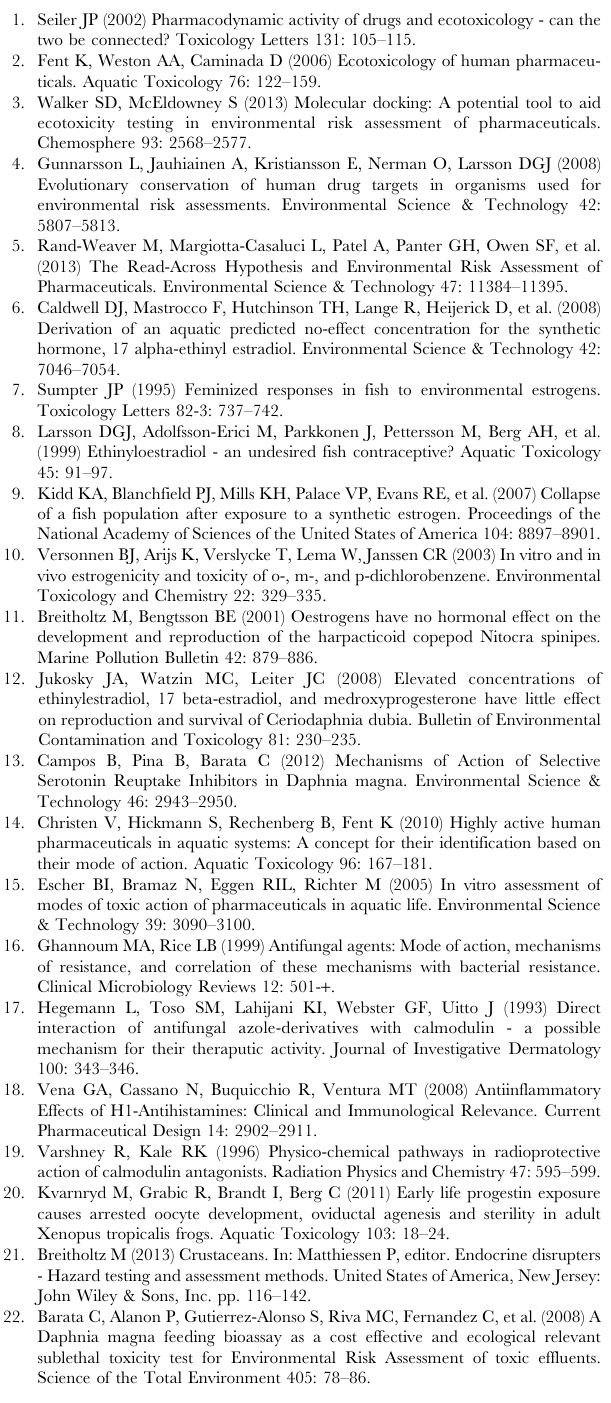
exposure. Error bars represents confidence interval (95%). Asterisk indicates significant difference in offspring production compared to control group (p # 0.05). Note different scales on the x-axis. Table S1 Measurements of pH and oxygen at the start and end of each exposure for acute tests, reproduction test and RNA/gene expression